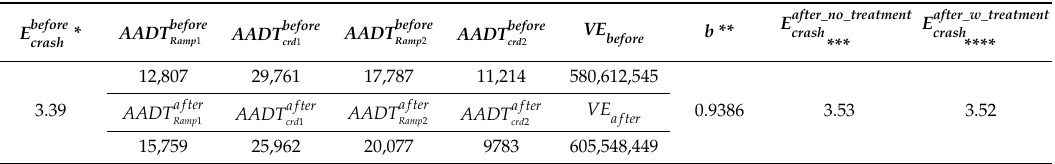
Table 2. EB method-based before-and-after crash frequency comparison at Intersection 1 (Loop 82, Aquarena Springs Drive at IH 35).